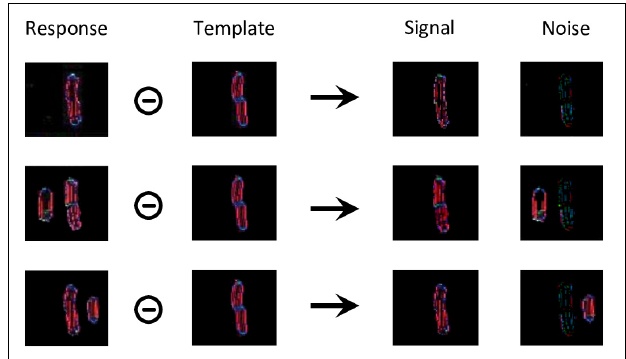
FIGURE 8 | Threshold computation, taking as an example the output generated by the segmentation model for all stimuli of experiment 1b of Manassi et al. (2012; see Figure 3A ). The output of the segmentation model for these stimuli do not look like straight lines, because the input is distorted by the retina model. For all these conditions, the target corresponds to the shape in the template array. The template was built by presenting the target alone to the visual system and taking the mean of the segmentation model’s output over several time-steps. The circled minus sign represents the following computation. After taking the mean of the arrays over all orientations, any pixel from the response array is multiplied by the value of the same pixel of the template array to obtain the value of the same pixel in the signal array, and by 1 min the value of the same pixel of the template array to obtain the value of the same pixel in the noise array. In other words, the pixels that match the template are assigned to the signal, and the ones that do not correspond to it are assigned to noise. Then, the threshold is computed as a measure of interference between the signal and the noise arrays, according to equation (1).